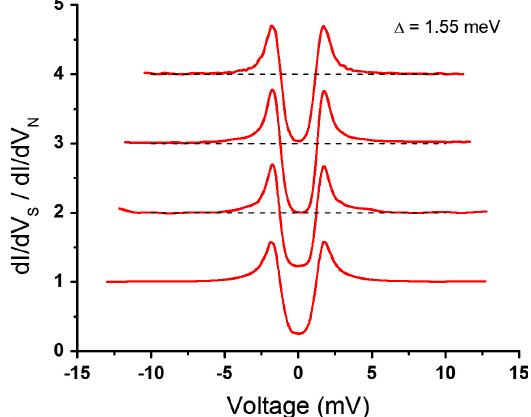
FIG. 17. Typical tunneling spectra obtained for different junc- tions on sample L50 offset vertically for clarity. The junctions obtained in L50 showed a consistent gap value of 1.55 meV and large coherence peaks (small (cid:3)